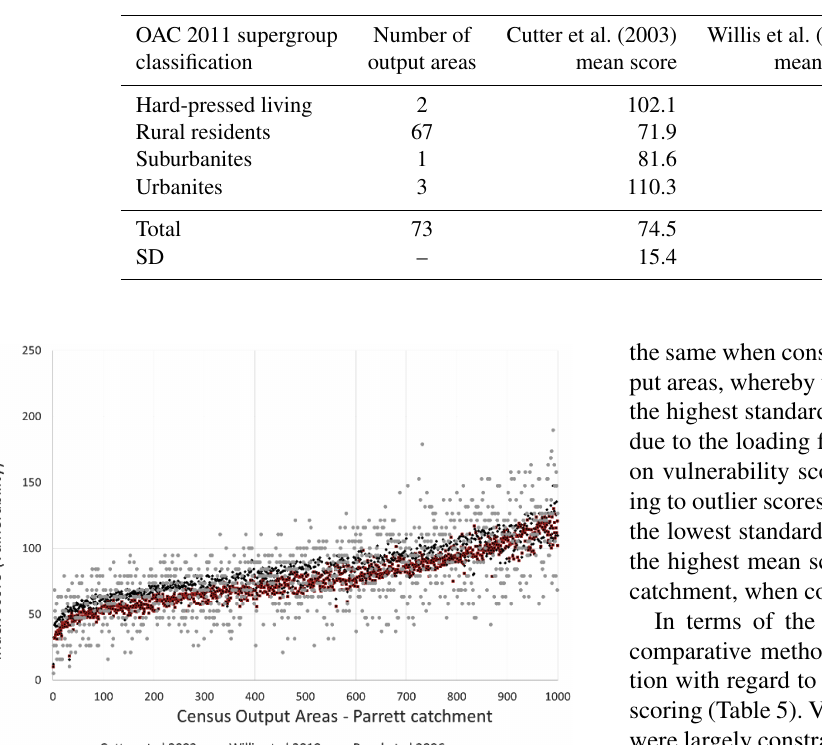
Table 6. Analysis of the areas impacted by the 2013/2014 flooding of the Somerset levels.